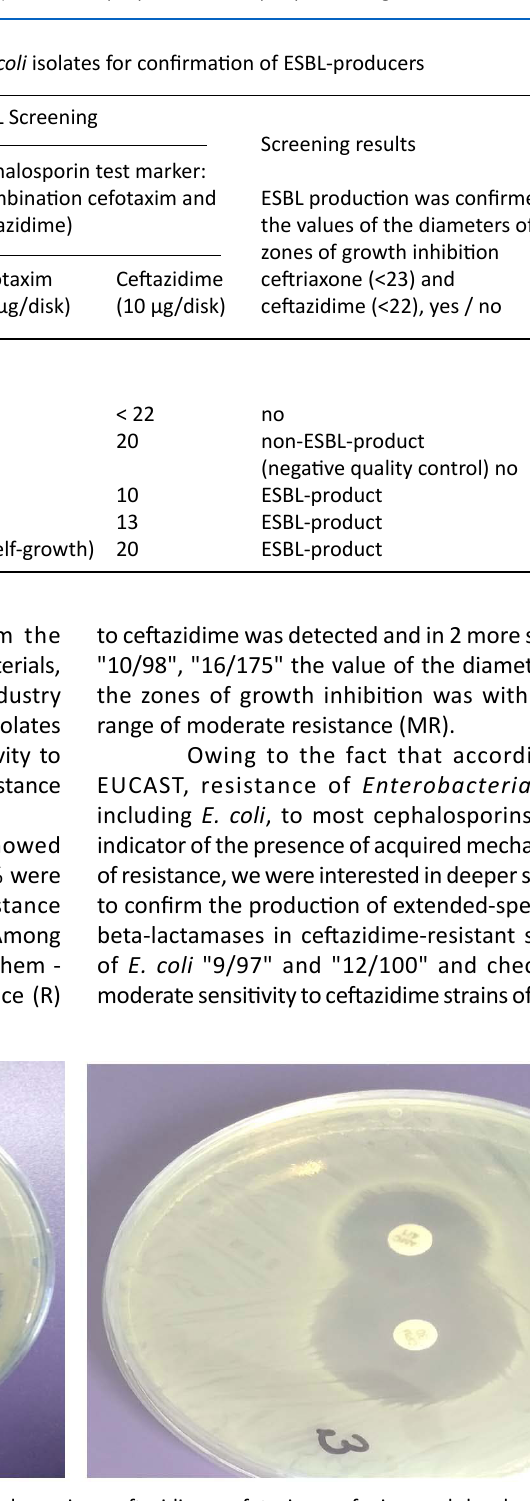
Fig. 1. Double-disc synergy test (DDST) with cephalosporins - ceftazidime, cefotaxime, cefepime and clavulanic acid, the "keyhole" effect , E. coli strain